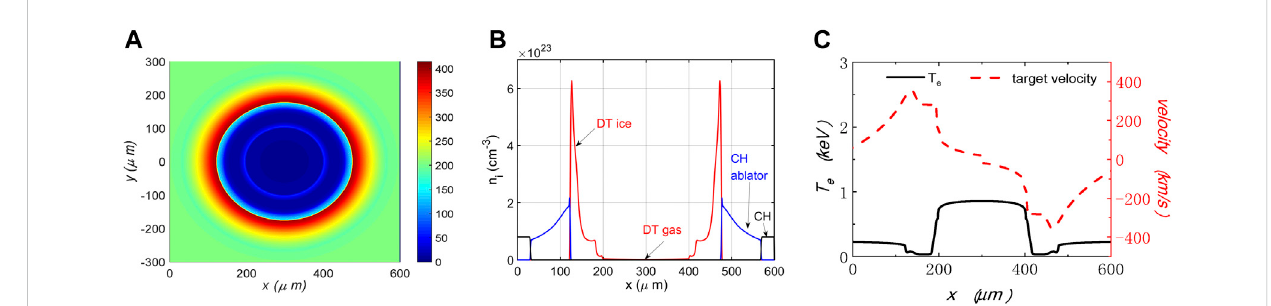
FIGURE 2 The initial pressure and density pro fi les of the hybrid fl uid-PIC simulations, which are extracted from the RDMG simulation. (A) the 2D pressure pro fi le in a unit of Mbar, (B) slice of the density pro fi le, (C) slice of electron temperature and target velocity along